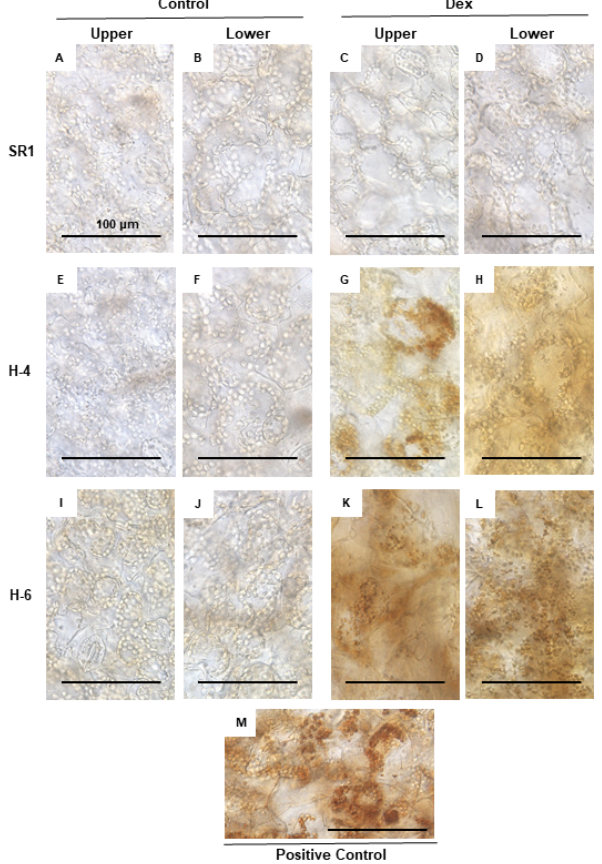
Figure 6. H 2 O 2 production in the chloroplasts of leaves developing chlorosis. Control plants (SR1; A – D ), i-hpHSP90C transgenic line 4 (H-4; E – H ), and line 6 (H-6; I – L ) plants were grown and treated with control or Dex solution. At 24 h post-treatment, leaf disks of 6 mm in diameter were cut out from upper and lower leaves, vacuum-infiltrated with DAB solution, and incubated under light conditions (70–100 µmol m –2 s –1 for 30 min). Untreated SR1 plants illuminated with 250–300 µmol m –2 s –1 for 60 min served as a positive control ( M ). All leaf disks were incubated in the dark for 3.5 h,